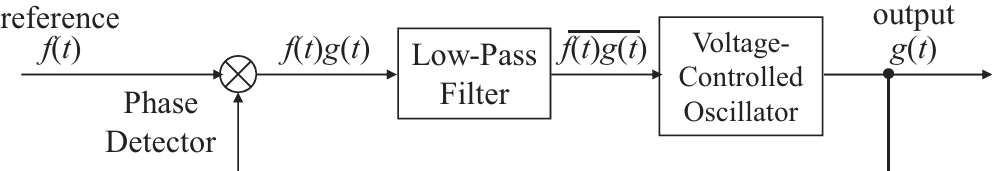
Figure 2. Block diagram of a PLL.